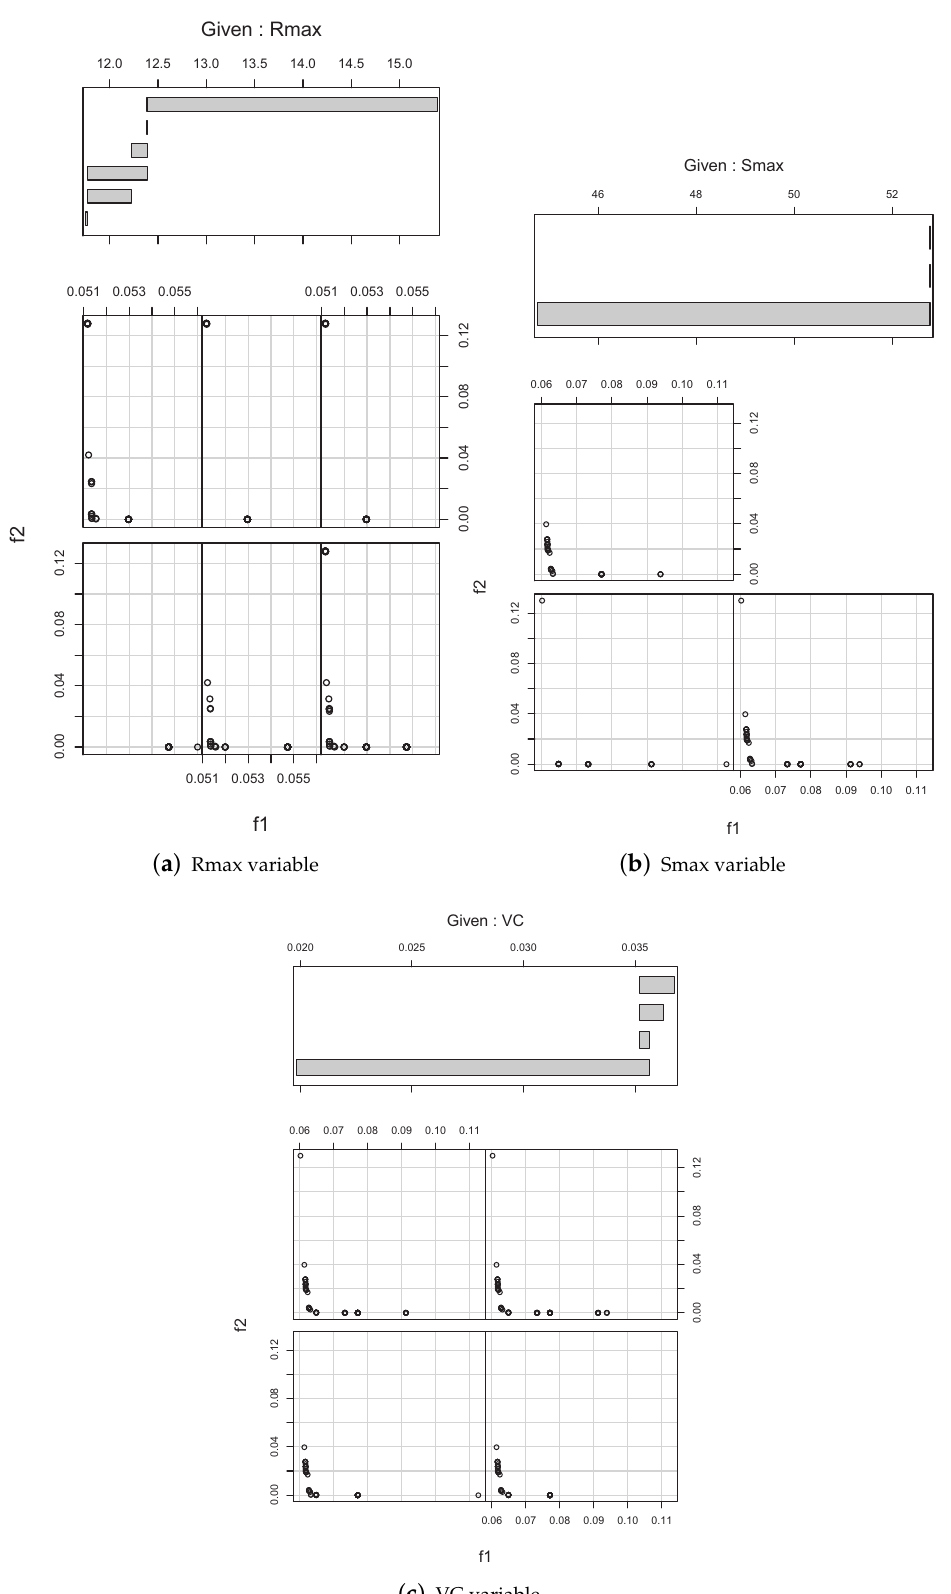
Figure 7. Rmax ( a ), Smax ( b ) and VC ( c ) variable values with regards to the reference front approximation obtained for problem instance series 2.2CC. Each sub-figure shows the range of values calibrated for each parameter ( top ) with regards to the reference front of solutions with their two objectives f1 and f2 ( bottom